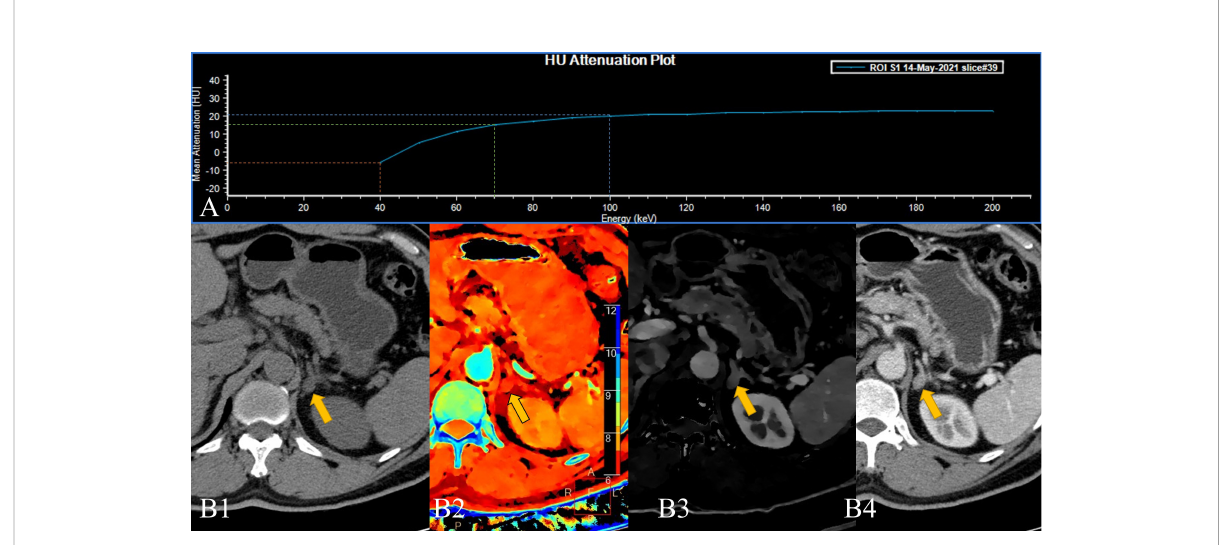
FIGURE 2 A 58-year-old male patient with a left adrenal lesion (yellow arrow); the pathological result was adrenal adenoma. (A) . The 40 – 200 keV HU attenuation plot (revealing an “ inverted ” curve). (B1) . Routine plain scan, (B2) . The effective atomic number can measure the effective atomic number of the lesion, and (B3) . Arterial phase iodine concentration (AP-IC) has poor resolution, but it can quantitatively analyse the iodine concentration in the lesion. (B4) . The 40 keV VMI based on arterial phase-enhanced reconstruction can not only perform a more detailed analysis of the lesion but also improve the